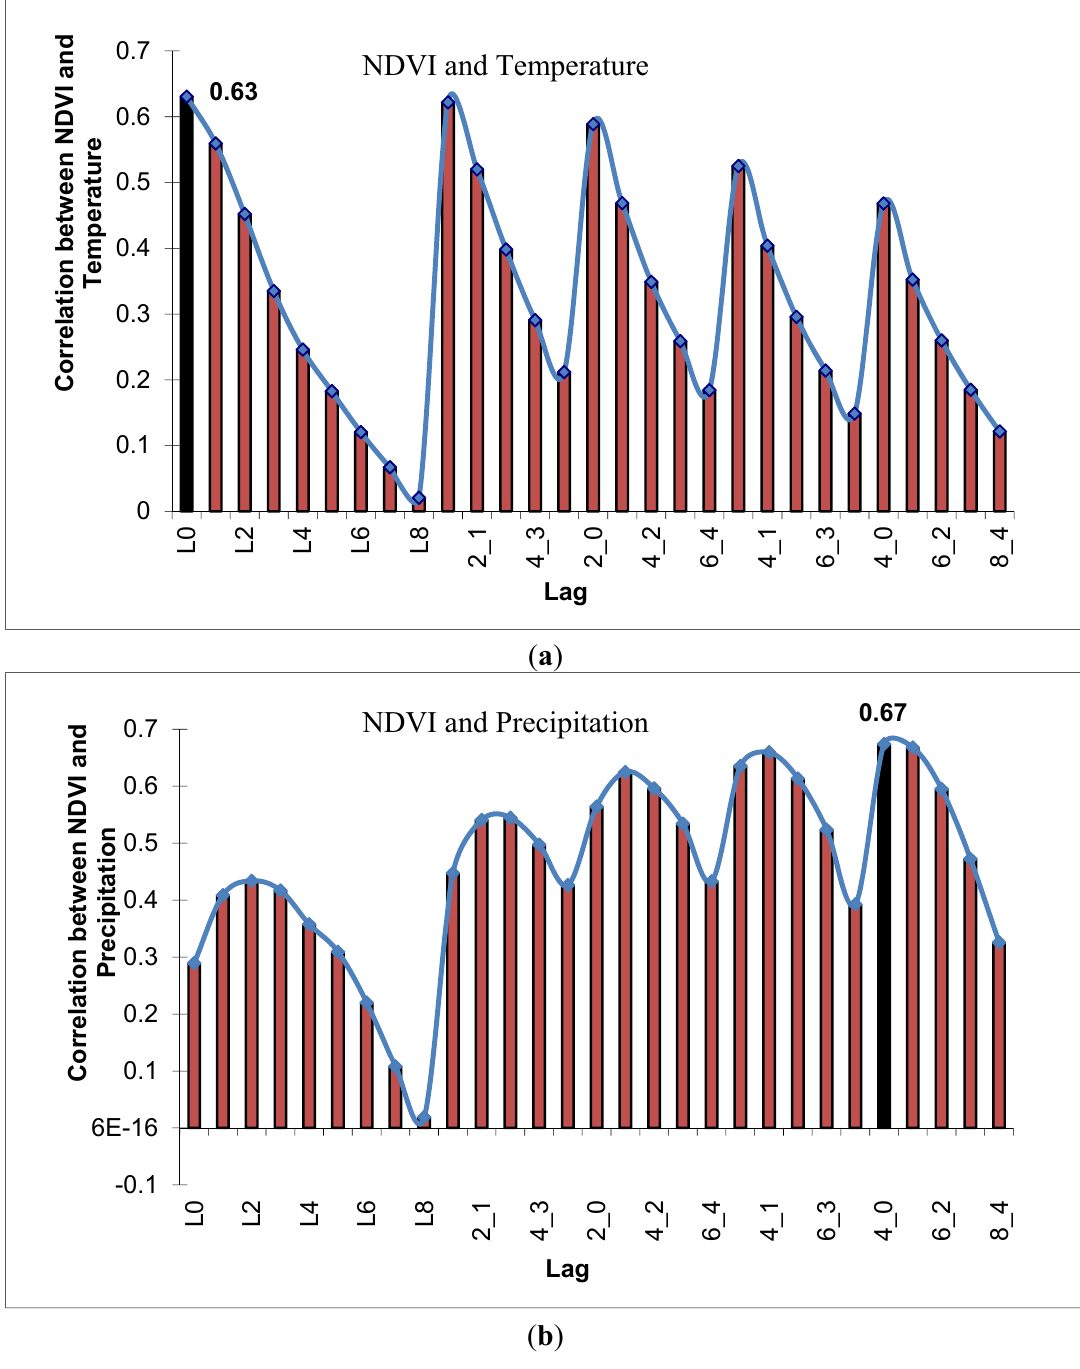
Figure 3. Intra-annual relationships between ( a ) NDVI and temperature, and ( b ) NDVI and